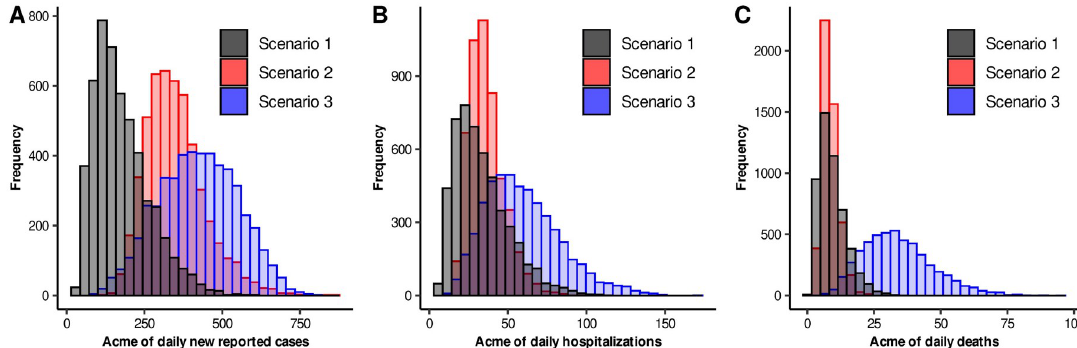
Fig 4. Histograms of acme levels for different epidemic curves. Black, red and blue bars are related to Scenarios 1, 2, and 3, respectively. A) acme of daily new reported cases. B) acme of daily hospitalizations. C) acme of daily deaths.